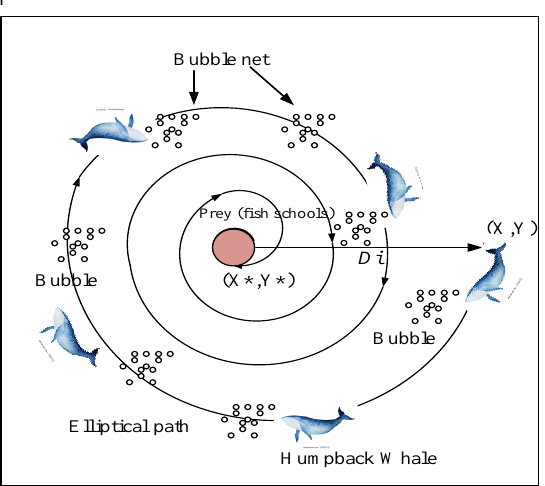
Figure 8. The spiral movements of humpback whales when hunting prey. (1) Encircling prey After noting the prey (school fish), the humpback whales set out to encircle and at- best whale 𝑤 ∗ is closest to the prey. Equation (19) shows the distance between the whale i and the target prey.